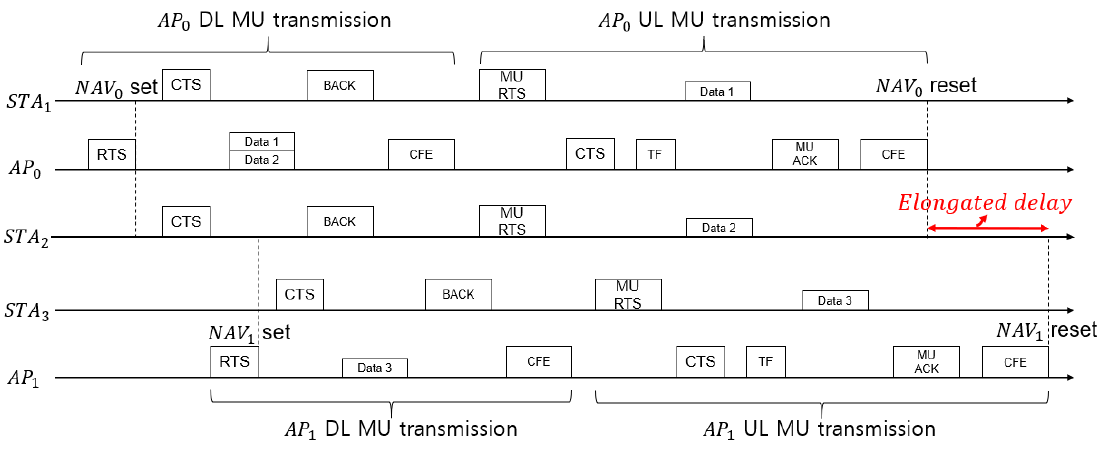
Figure 5. Elongated delay scenario of STA 2 due to inter-BSS NAVs NAV 1